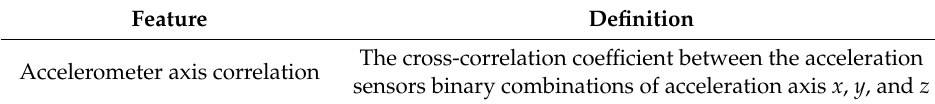
Table 4. Cross-correlation